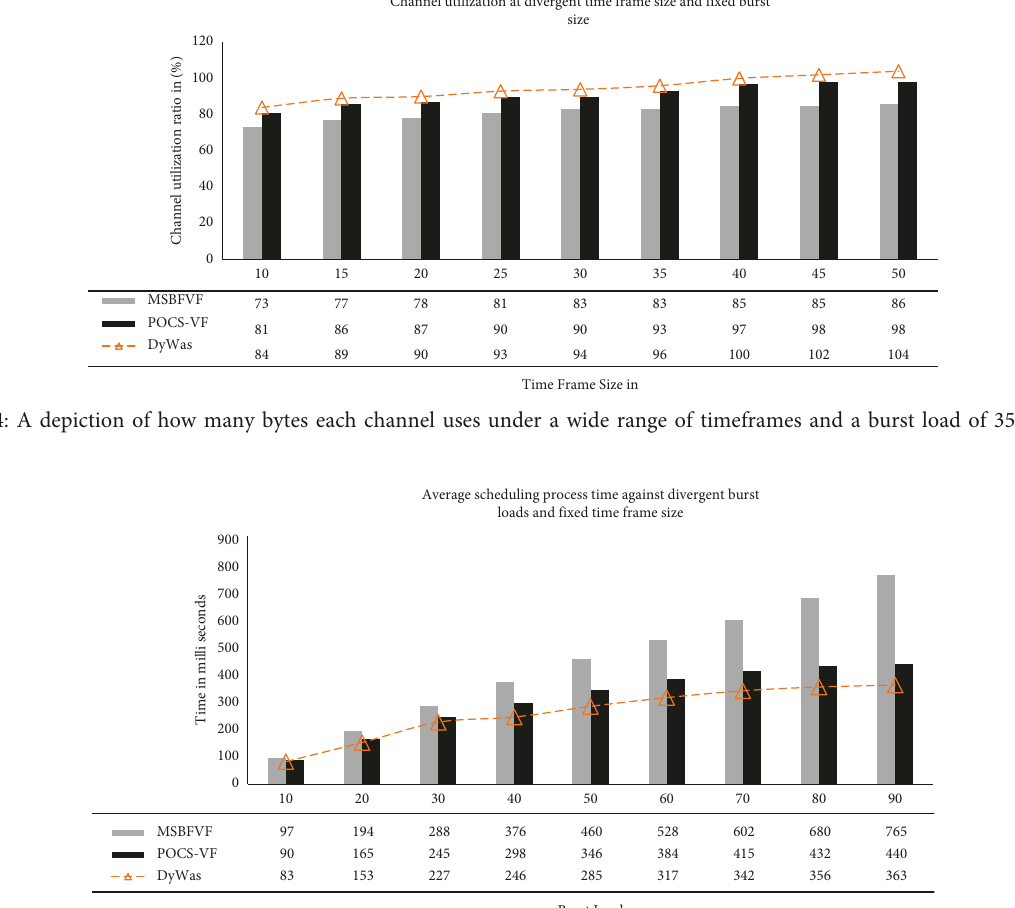
Figure 5: Depiction of average time to schedule burst: divergent burst loads with the fixed time frame of size 25.